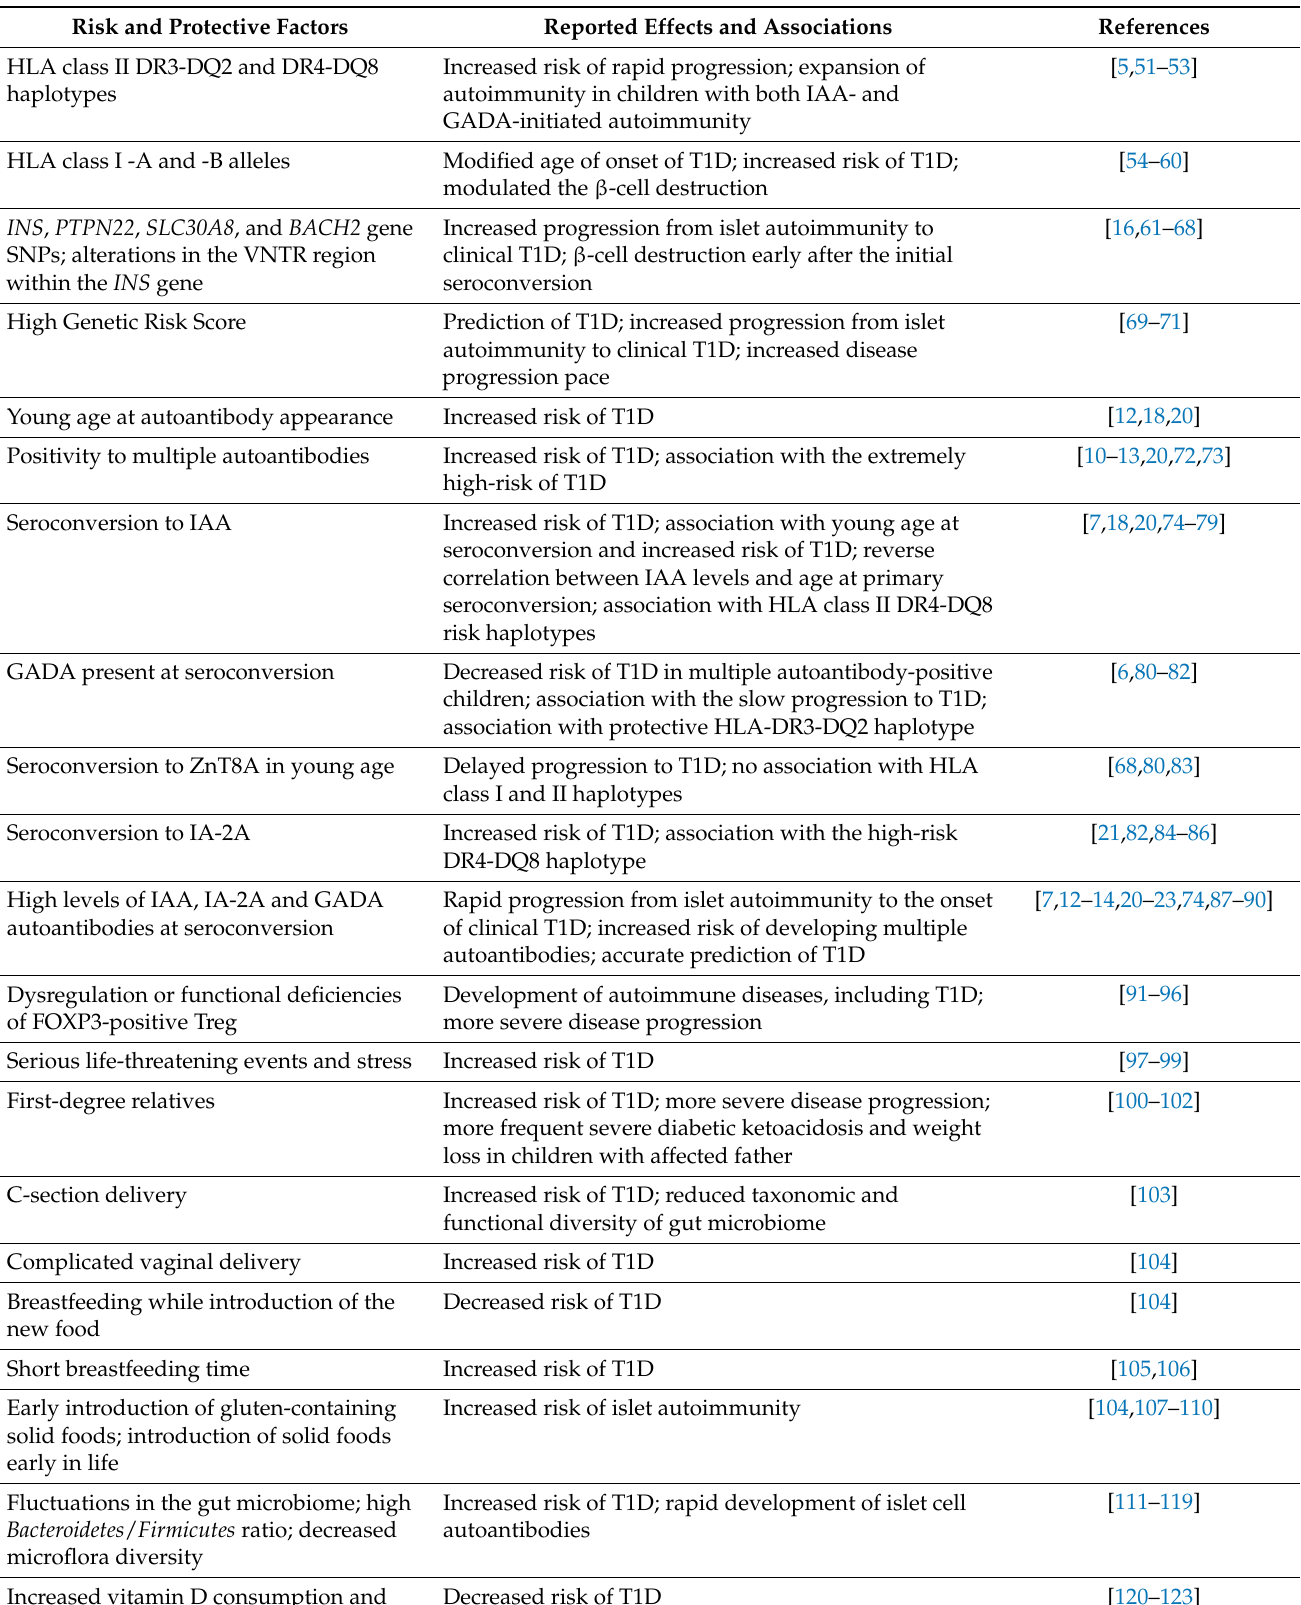
Table 1. Main categories of factors affecting the progression of islet cell autoimmunity and T1D development. Risk and Protective